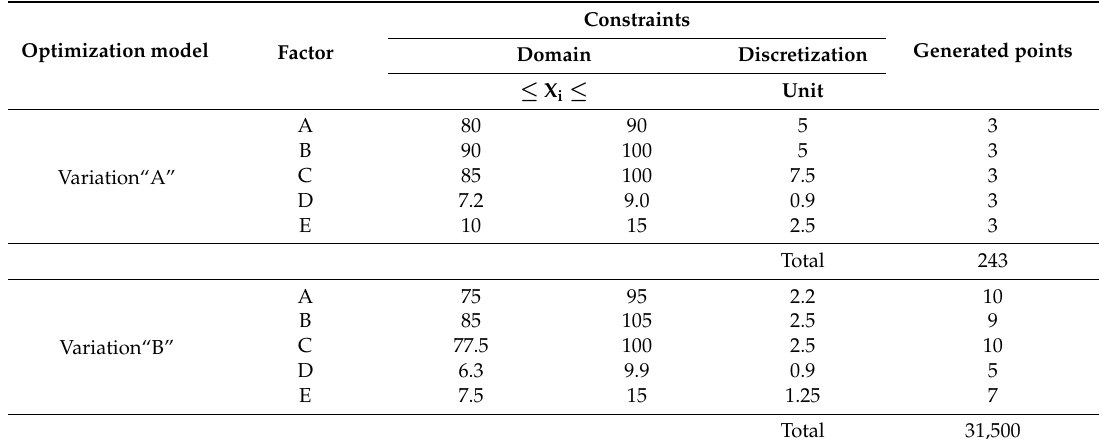
Table 5. Restrictions domain used for optimization model “A” and model “B”.